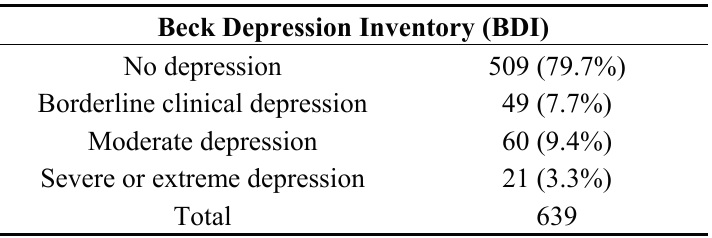
Table 9. Percentage of students in each